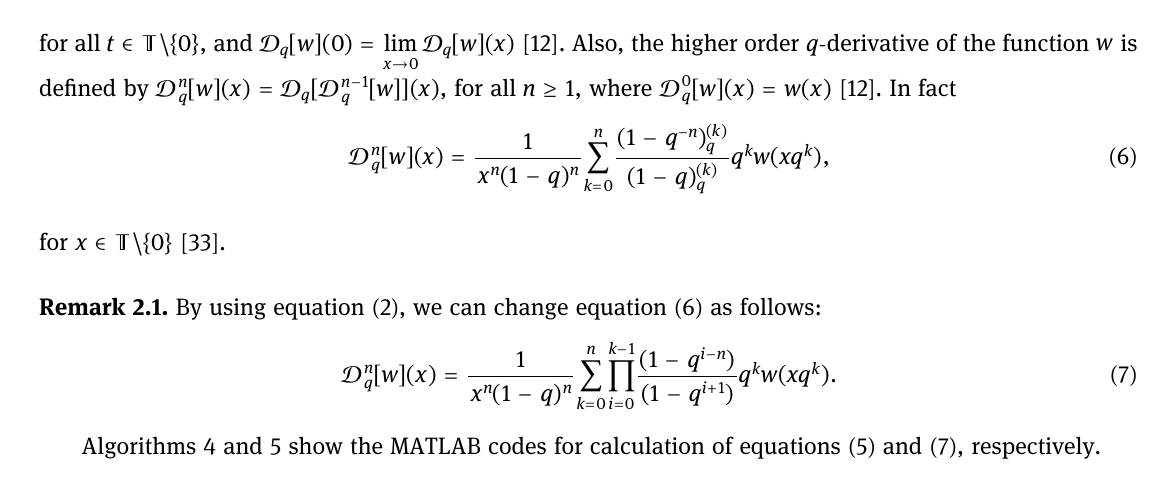
Algorithm 4. MATLAB lines for calculation of